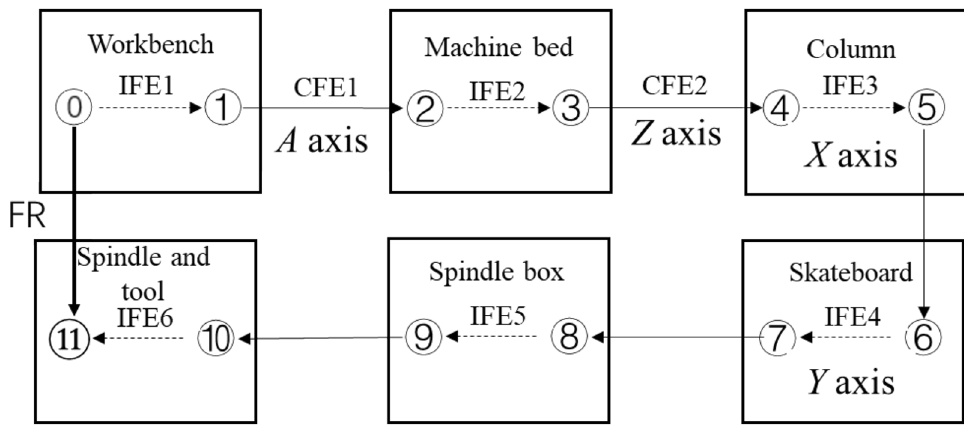
Figure 6 Connection graph of functional pairs